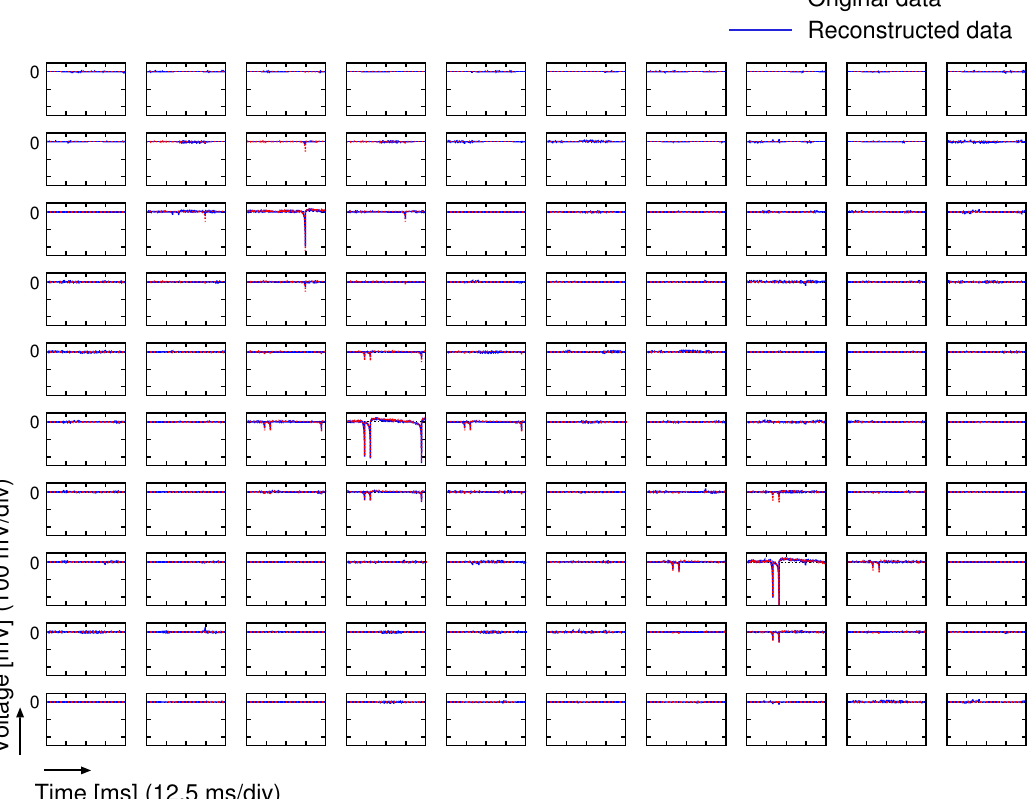
Figure 17. 100-ch. reconstructed temporal waveforms from the compressed data encoded by the prototype CS encoder at CR =